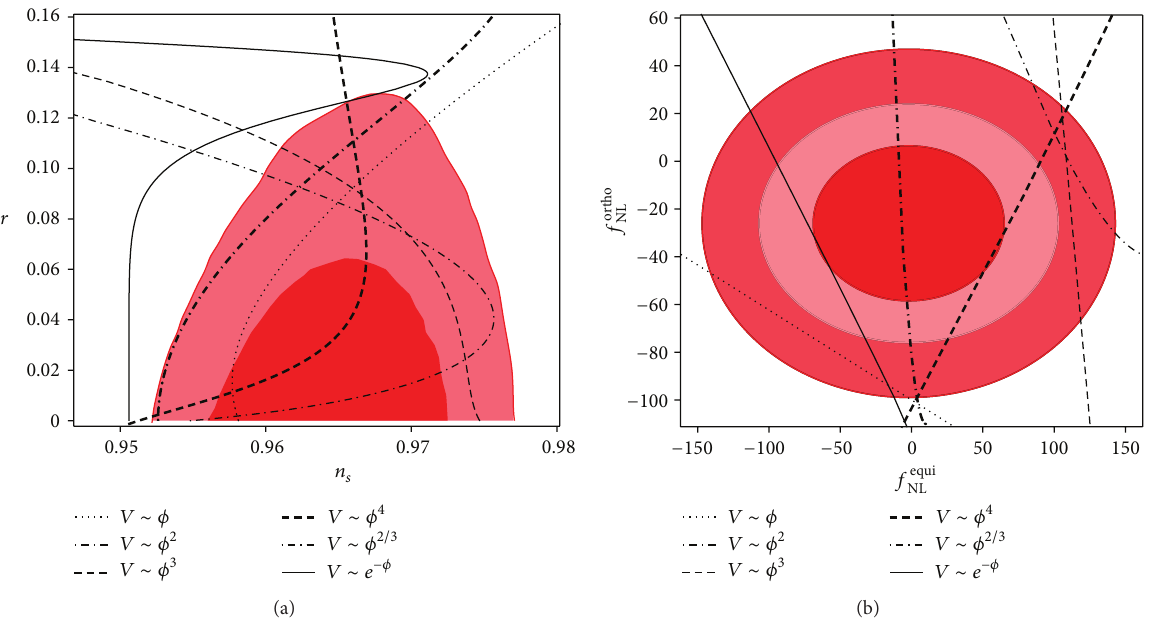
Figure 2: Tensor-to-scalar ratio versus the scalar spectral index for an inflationary model in which both inflaton and its derivative are nonminimally coupled to gravity, in the background of the Planck 2015 TT, TE, and EE + lowP data (a) and the amplitude of the orthogonal configuration of non-Gaussianity versus the equilateral configuration for an inflationary model in which both inflaton and its derivative are nonminimally coupled to gravity, in the background of Planck 2015 TTT, EEE, TTE, and EET data. (b). Figure is plotted with 𝑛 = 1 , 𝑓(𝜙) ∼ 𝜉𝜙 4 , and various types of potential, for 𝑁 = 60 .